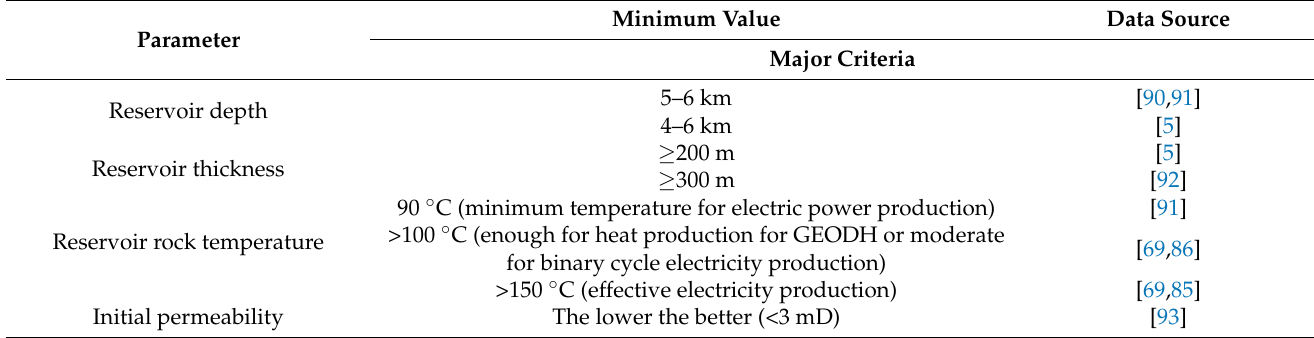
Table 2. List of criteria and parameters conditioning preliminary selection of geological structure for EGS system based on a literature